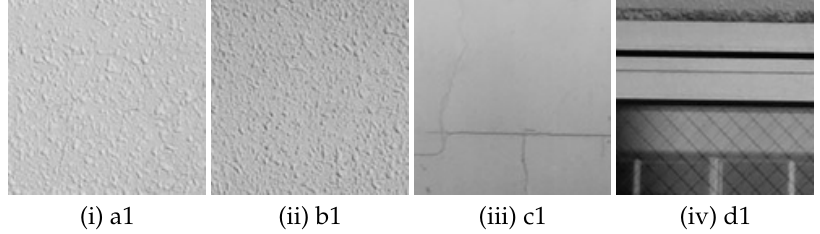
Figure 3. Examples of sub-image extracted from area A to D captured by a fixed